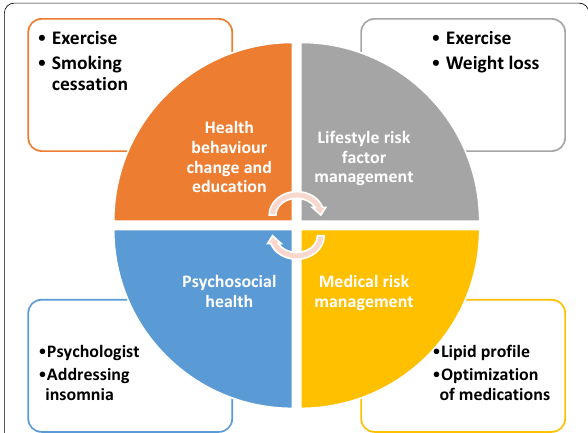
Fig. 1 Components of an efficient cardiac rehabilitation